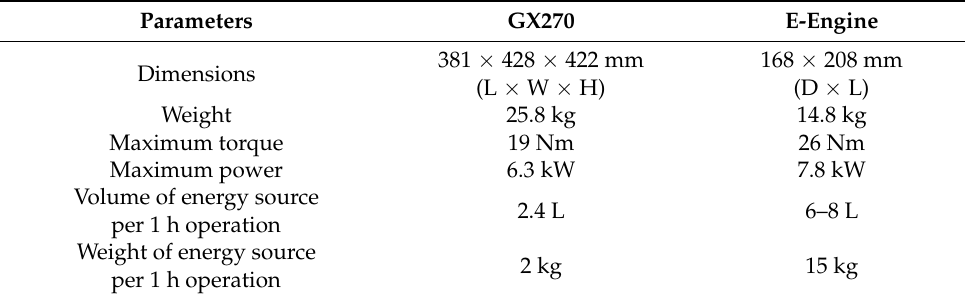
Table 2. Comparison between the ICE Honda GX270 and E-engine.